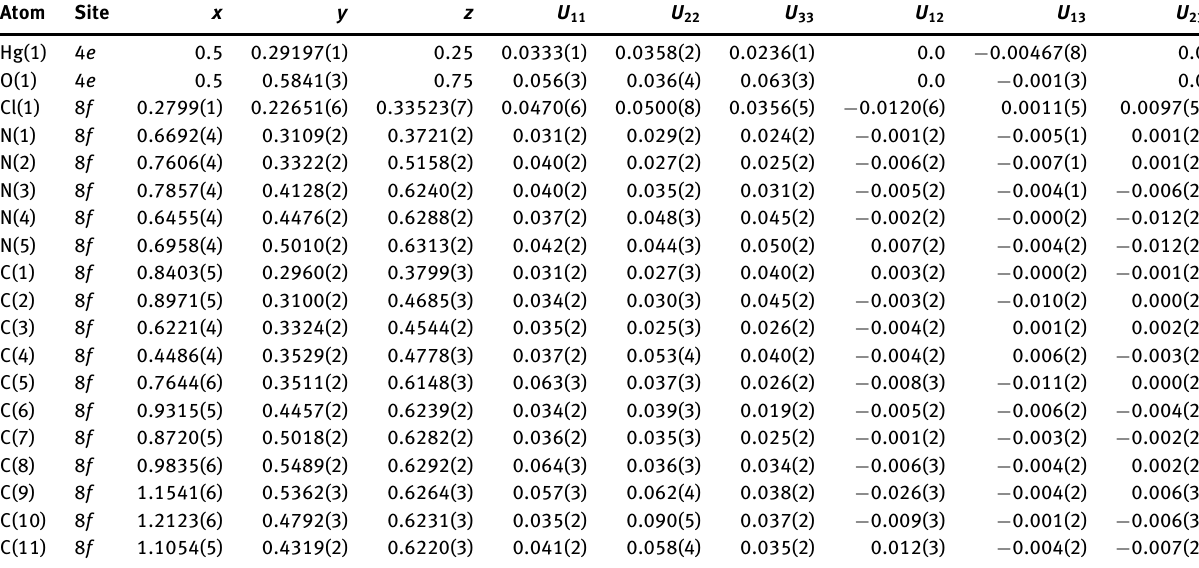
crystal X-ray diffraction reveals that the title structure consists of mononuclear complex as shown in the figure [11, 12]. The Hg atom is five-coordinated by two N atoms of two 1-[(benzotriazol-1-yl)methyl]-1- H -1,3-(2-methyl-imdazol) ligands, two chlorido and one water ligand. The bond lengths of Hg-N and Hg-Cl are 2.175(3) Å and 2.6092(11) Å, respec- tively. The dihedral angle between the N1/Hg1/N1a and Cl1/Hg1/Cl1a planes is 92.3(2)°. In the crystal, the adjacent molecules are stacked through the aromatic π–π interactions (the centroid-centroid distances between imdazol rings is 3.531 Å,andthecentroid-centroiddistancesbetweenbenzene rings are 3.578 Å and 3.590 Å.)